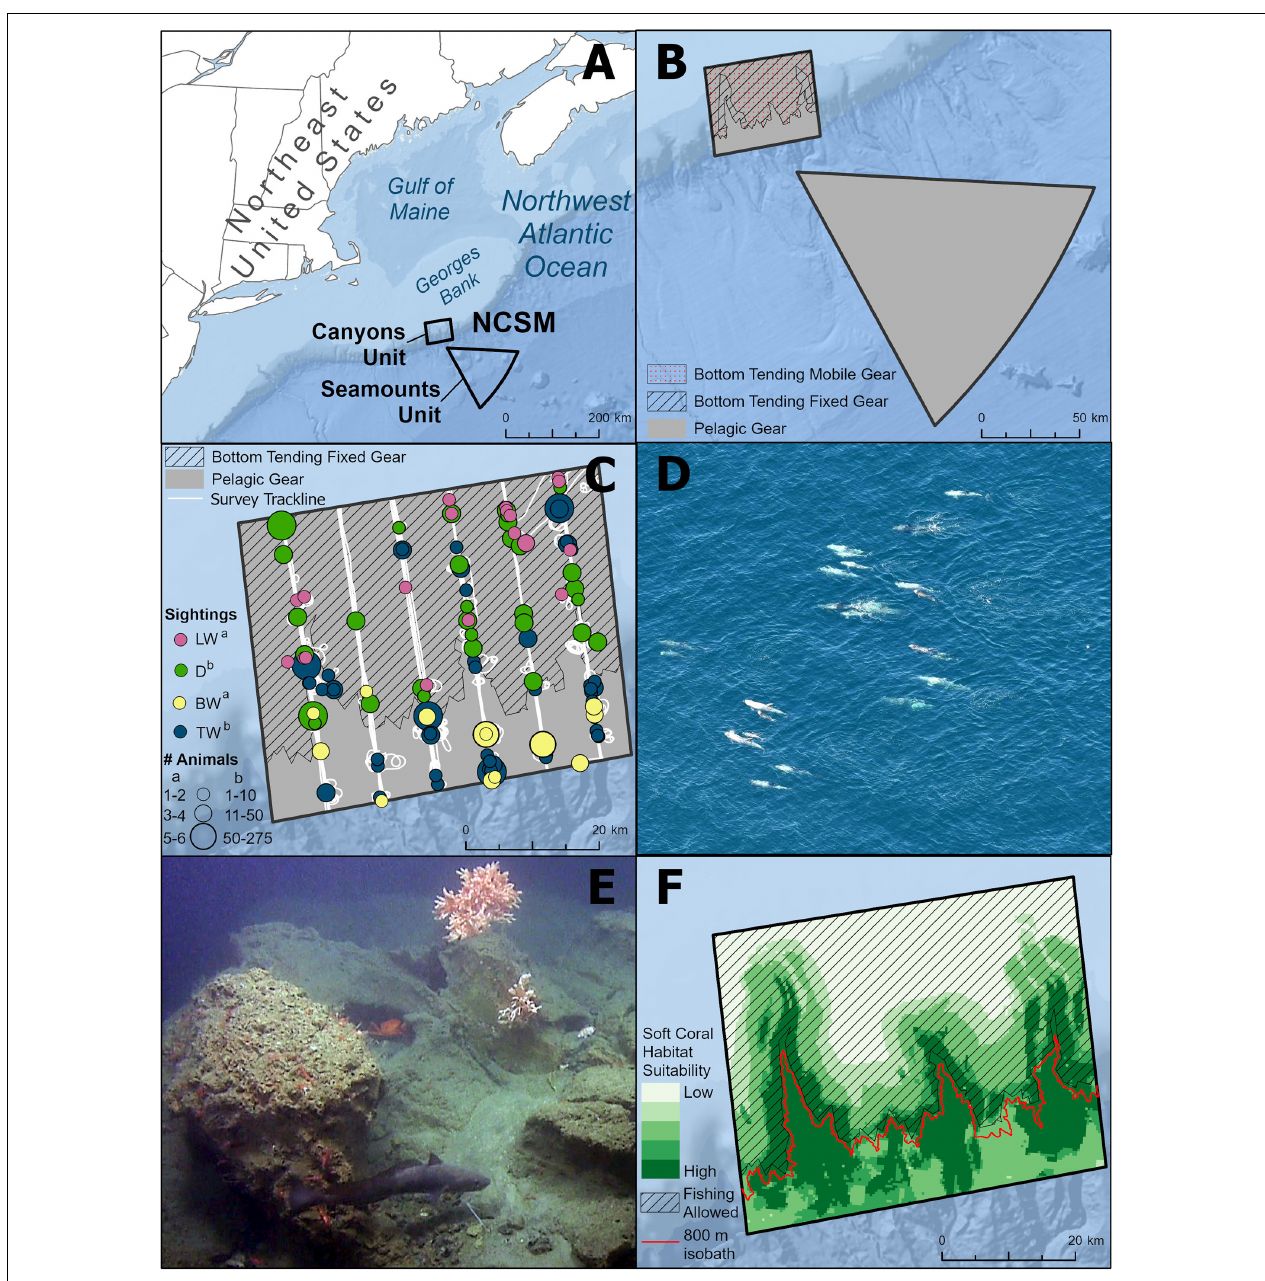
FIGURE 1 | (A) The Northeast Canyons and Seamounts Marine National Monument (NCSM). (B) Although the Magnuson-Stevens Fishery Conservation and Management Act (MSA) excludes bottom tending mobile and fixed gear from the deeper waters of the NCSM through the proposed Omnibus Deep-Sea Coral Amendment and the Lydonia and Oceanographer Canyons Gear Restricted Areas, a majority of the NCSM canyons unit is open to fishing with these gear types. The MSA also leaves the entire NCSM open to pelagic fishing. (C) Encounter rates for large whales (LW: blue, fin, humpback, and sei whales), which feed primarily on krill and small schooling fish, were higher in areas that are open to fishing with bottom tending fixed gear. The same was true for common, Atlantic spotted, and bottlenose dolphins (D), which are generalist feeders. However, striped dolphin (D), which are also generalist feeders, encounter rates were higher in areas protected from bottom tending fixed gear. Encounter rates were also higher in protected areas for species that feed primarily on squid, including beaked whales (BW: Cuvier’s, Sowerby’s, and True’s beaked whales) and other toothed whales (TW: sperm whales, pilot whales, and Risso’s dolphins). (D) A group of Risso’s dolphins that includes mothers with calves. (E) Example of deep coral ( Primnoa resedaeformis ) and associated fauna, including red crab and shortfin squid ( Chaceon quinquidens and Illex illecebrosus , respectively, both targets of fisheries), in cobble-boulder size sedimentary class habitat (depth 550 m, Oceanographer Canyon, 4 September 2019; image courtesy NOAA Okeanos Program). (F) Over a third of the region predicted to have the highest habitat suitability for soft corals (Kinlan et al., 2020) within the NCSM is unprotected by the proposed Omnibus Deep-Sea Coral Amendment (designated as fishing allowed in the map). The Omnibus does not exclude red crab fishing and the trap gear used to catch red crabs can impact deep-sea corals. If we consider red crab fishing, which can occur to 800 m depth, 46% of the highest suitable habitat is unprotected.